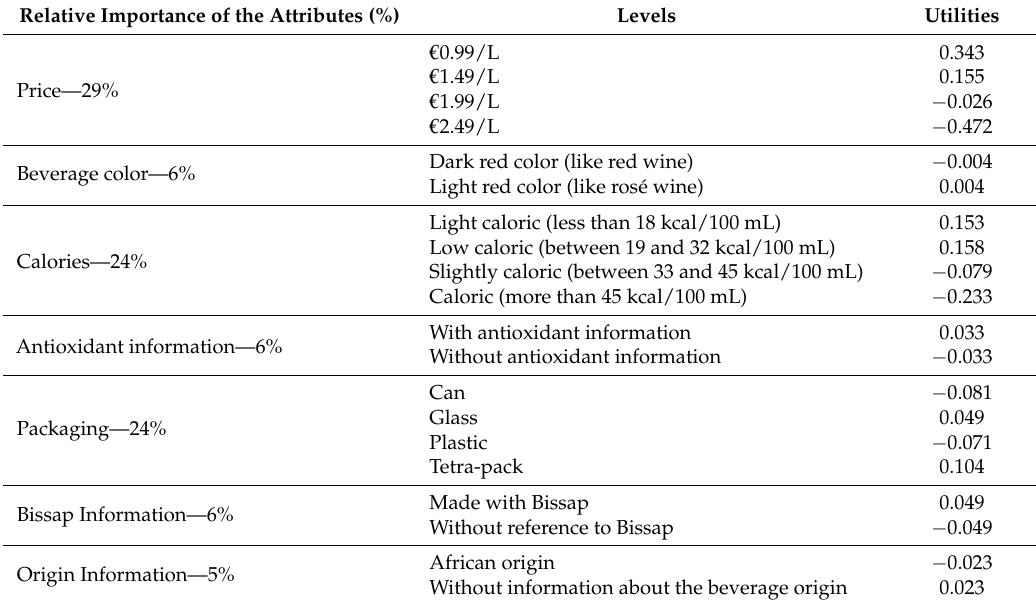
Table 7. Conjoint analysis results: relative importance of the attributes and utilities of the